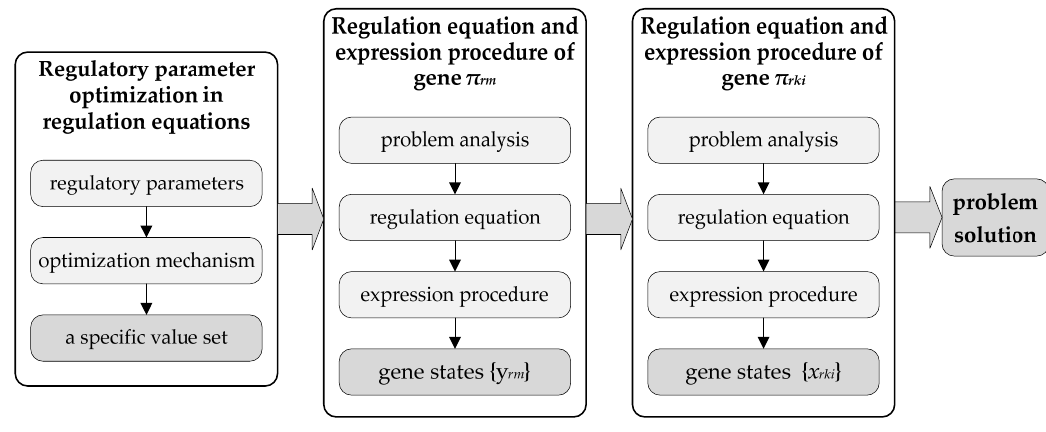
Figure 5. Outline of the GRN-based method.